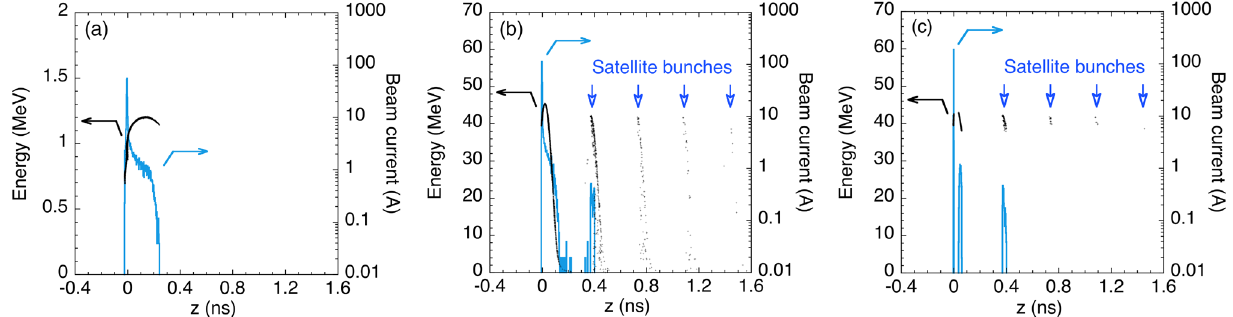
FIG. 5. Energy profile (black dots) and beam current (blue line) as functions of the bunch longitudinal position (time) for the SCSS injector simulated using PARMELA. (a), (b), and (c) correspond to the S-band structure entrance and exit and after the BC1 energy slit, respectively.